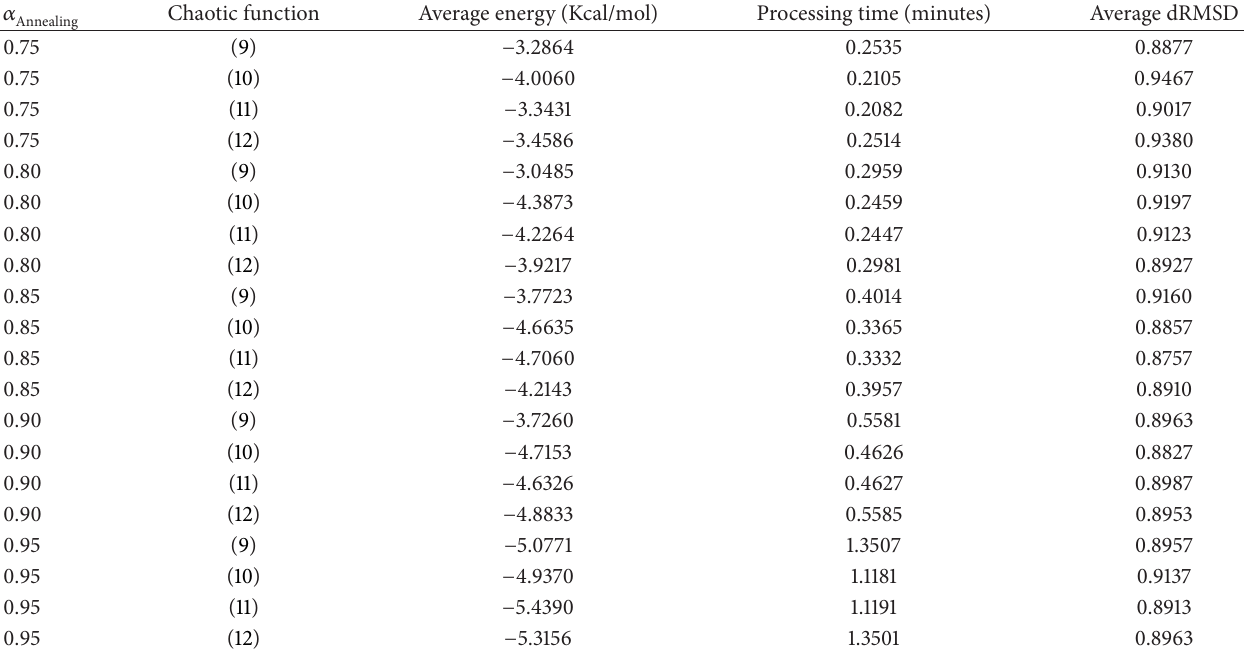
Table 2: Average results of Met 5 -enkaphalin.